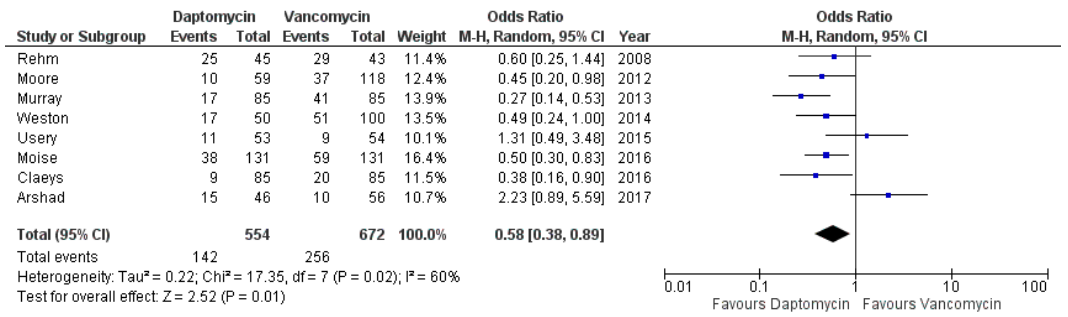
Figure 4. Forest plot depicting the adjusted odds ratio of clinical failure of patients receiving daptomycin vs. vancomycin.